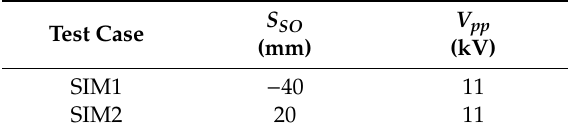
Table 2. Test matrix of electrostatic field